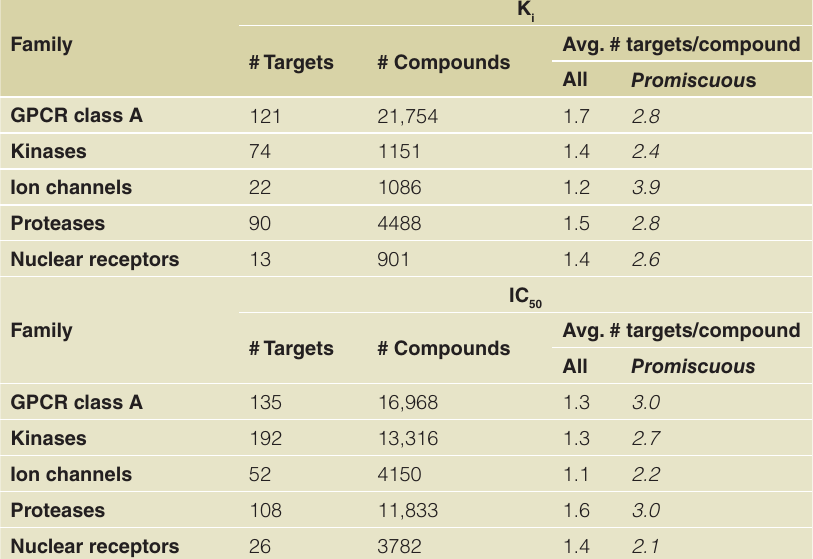
Table 3. Average promiscuity of compounds active against prominent target